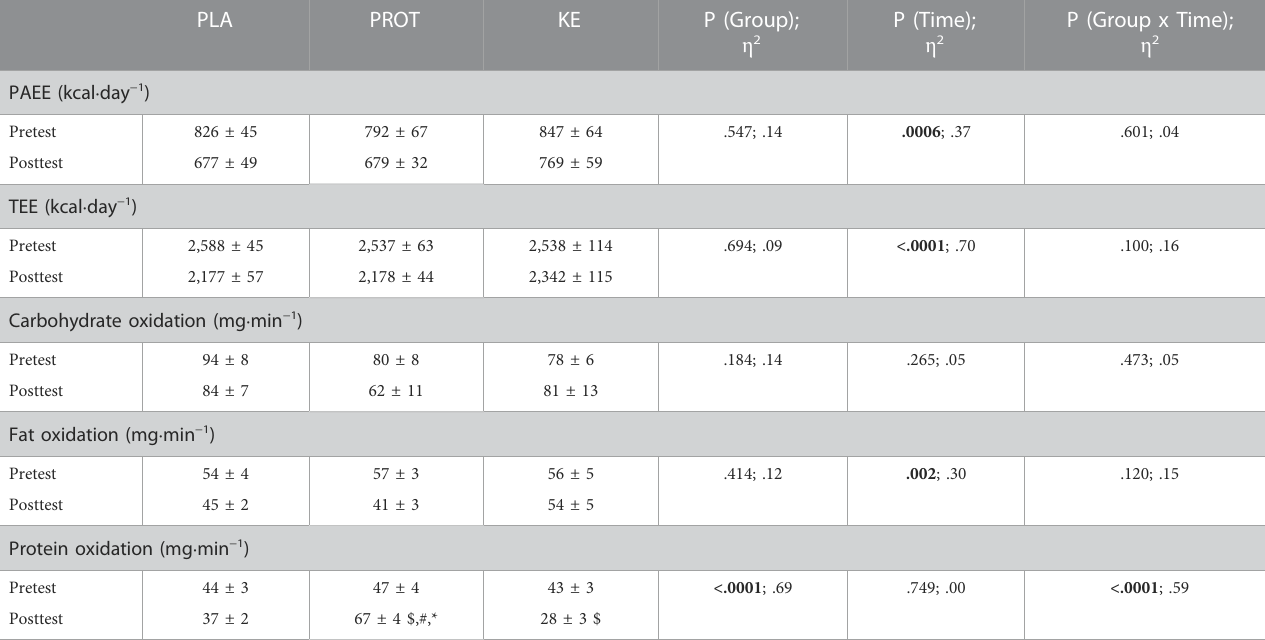
TABLE3Effectofincreased proteinintakeandexogenousketosisonphysicalactivity-relatedenergyexpenditure,totalenergyexpenditureandsubstrateoxidationat rest during ahypocaloric diet.Data are mean±SEM.Subjects wereinvolvedina4-week hypocaloricdiet(30%energy restriction,.8 – 1.0 gprotein · kgBW − 1 · day − 1 )and received either placebo (PLA), an increased amount of dietary protein (PROT) or a ketone ester (KE). Physical activity-related energy expenditure (PAEE; PLA: n = 11; PROT: n = 9;KE: n = 9) was measured during the registration period and during week threeof the caloric restriction period. Total energyexpenditure (TEE; PLA: n =